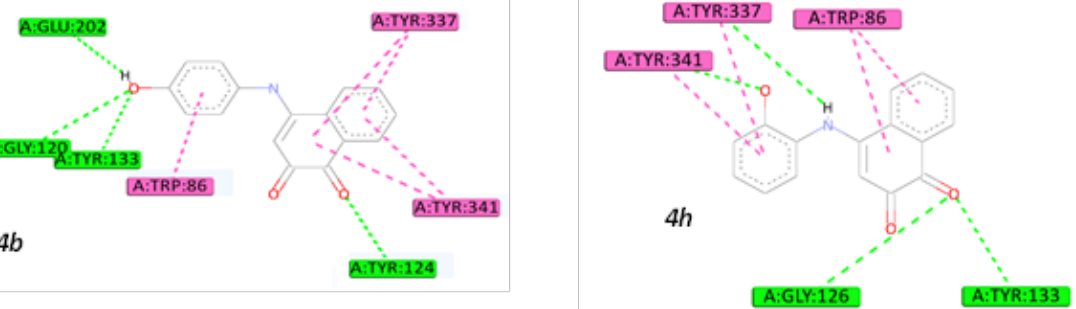
Figure 6. Binding mode prediction for compounds 4b and 4h with AChE (PDB id:4EY7) visualized in Discovery Studio, BIOVIA. Color coding: pink, π - π aromatic interaction; green, conventional hydrogen bond.